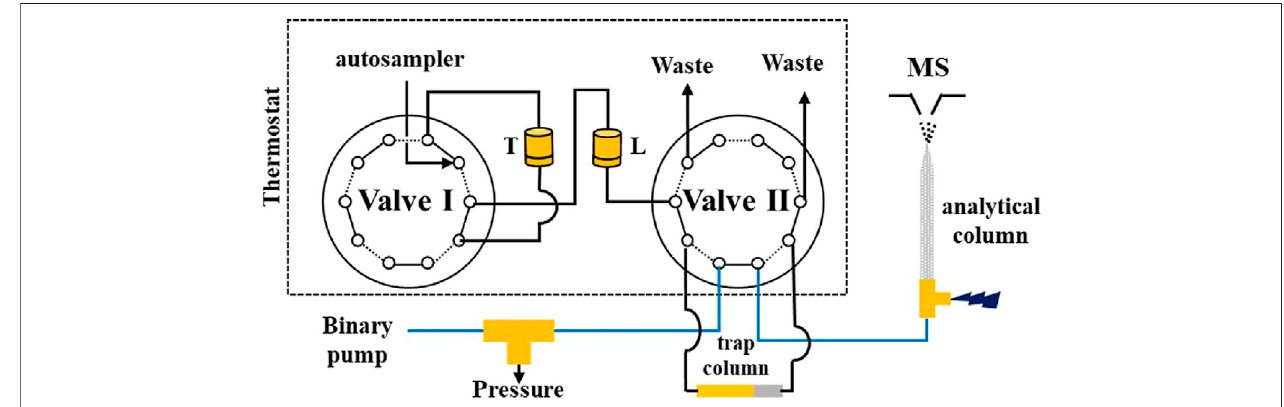
FIGURE 3 | Con fi guration of the serial TPPMRs for online proteolysis and glycopeptide enrichment prior to nLC-ESI-MS/MS, Setup con fi guration: Operational position 1 : on-line digestion and glycopeptides enrichment, Valve positions: I: solid and II: dotted lines. Operational position 2: PNGase F injection and loading to trap column, Valve positions: I: dotted and II: solid lines. Operational position 3: LC/MS run of deglycosylated peptide and re-conditioning of TPPMR, Valve positions: I: solid and II: dotted lines. TPPMR: thermoresponsive porous polymer membrane reactor. nLC-ESI-MS/MS: nano fl ow liquid chromatography-tandem mass spectrometry.T:TrypsinimmobilizedTPPMR.L:LectinimmobilizedTPPMR.ReprintedwithpermissionfromYangetal.,Anal.Chem.2018,90,3,124 – 3,131,Copyright © 2018, American Chemical